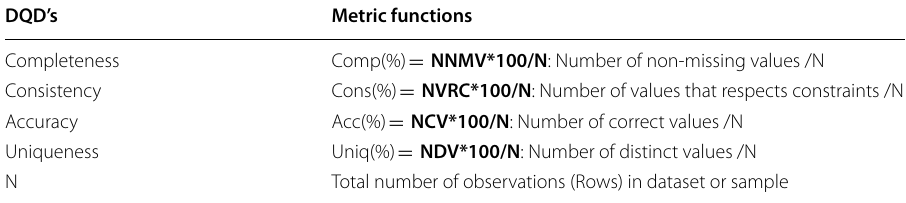
Table 2 – Example of data quality metrics DQD’s